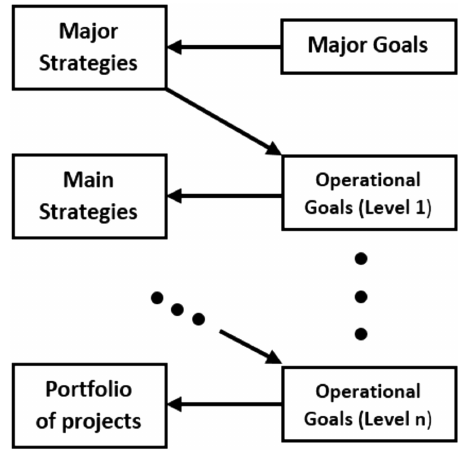
Figure 3. Hierarchical strategic